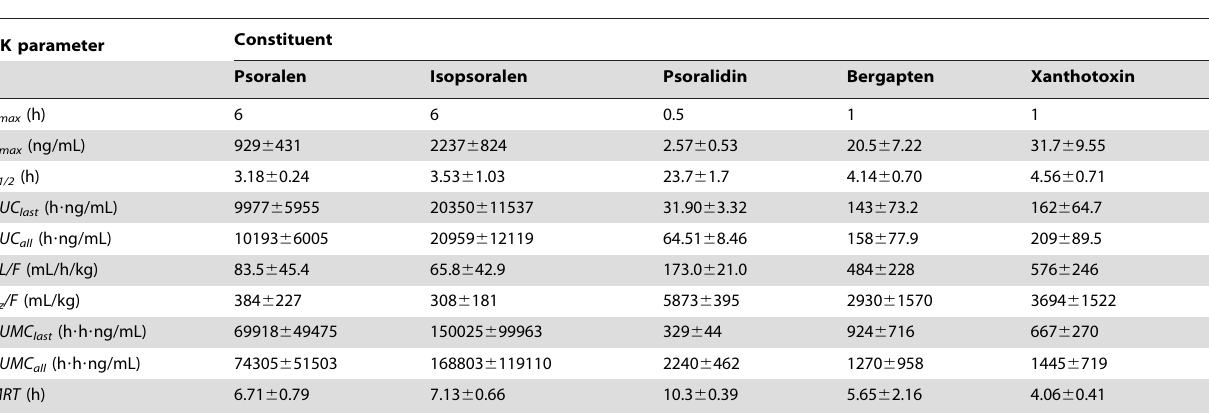
Table 3. Pharmacokinetic parameters of 5 constituents after single oral administration of BZ in SD rats.